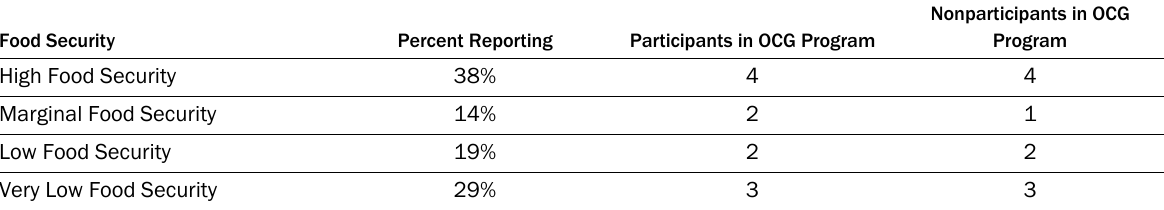
Table 4. Estimated Level of Food Security of Seniors Interviewed ( n =21) Food